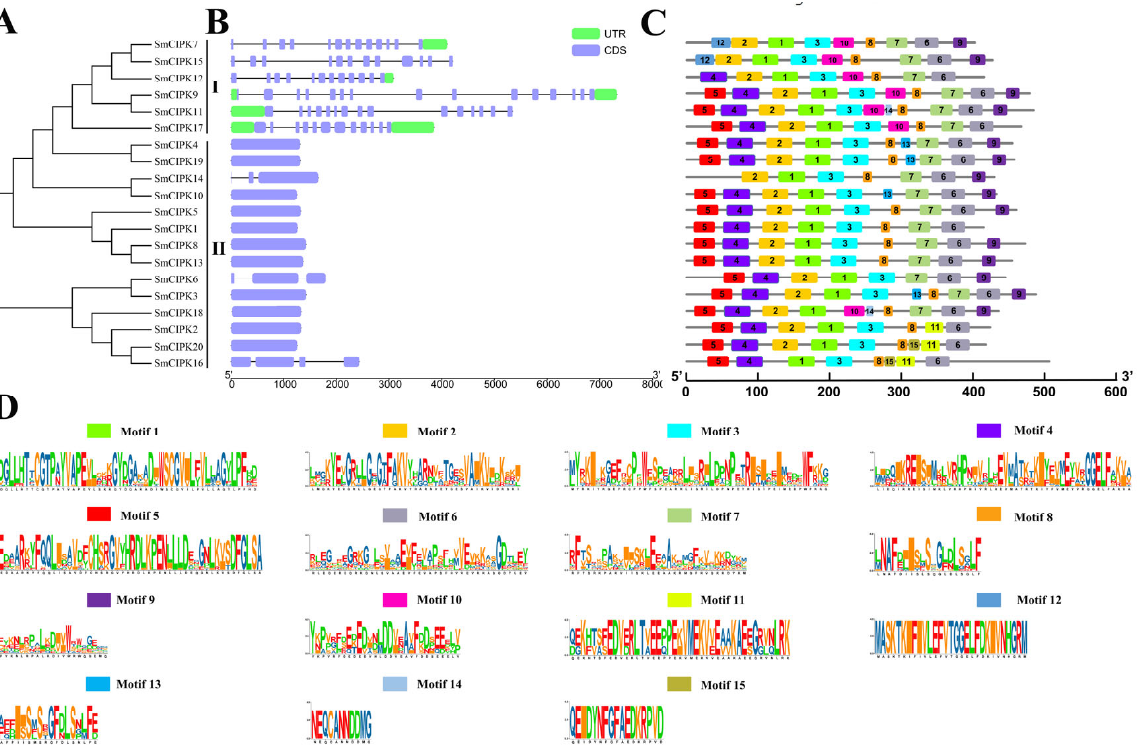
Figure 2. Phylogenetic relationship, gene structure and conserved motif analysis of SmCIPKs . ( A ). Phylogenetic tree of SmCIPKs. ( B ). Schematic diagram of intron and exon structures of SmCIPKs. Blue boxes represent exons, green boxes represent untranslated regions, and straight lines represent introns. ( C , D ). The different colored boxes represent different conserved motifs and specific amino acid sequences.